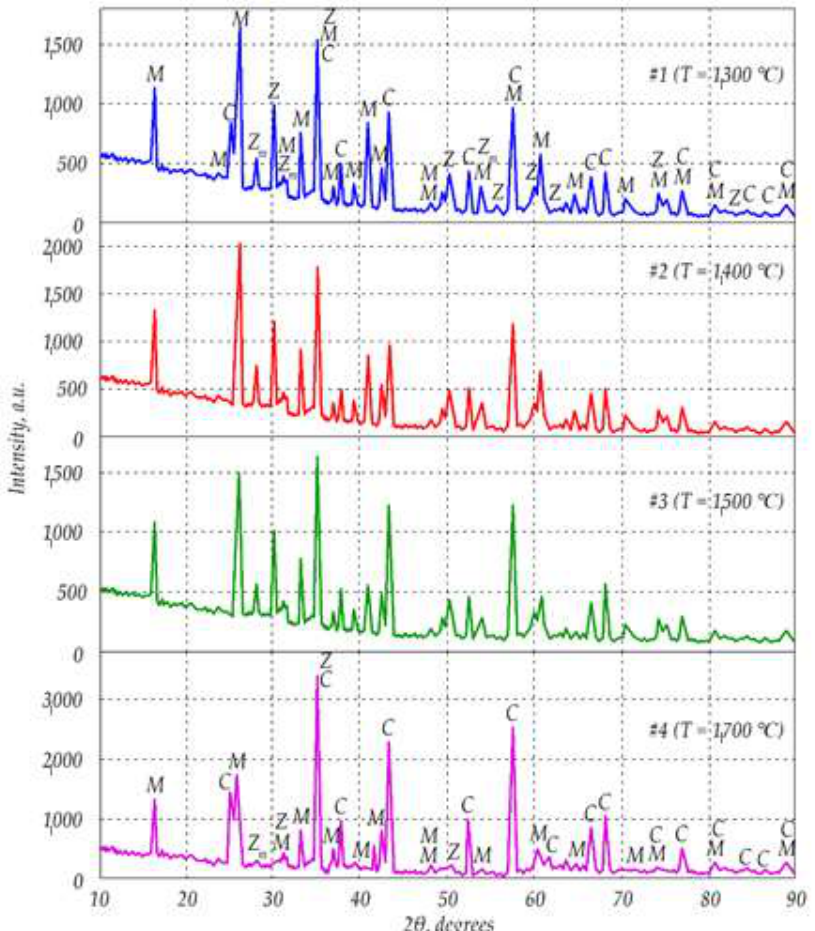
Figure 6. Diffractograms of the mullite-corundum ceramics sintered at different temperatures. M — mullite (3Al 2 O 3 ·2SiO 2 ), C —corundum (α–Al 2 O 3 ), Z —zirconia (ZrO 2 tetragonal), and Z m —zirconia (ZrO 2 monoclinic).